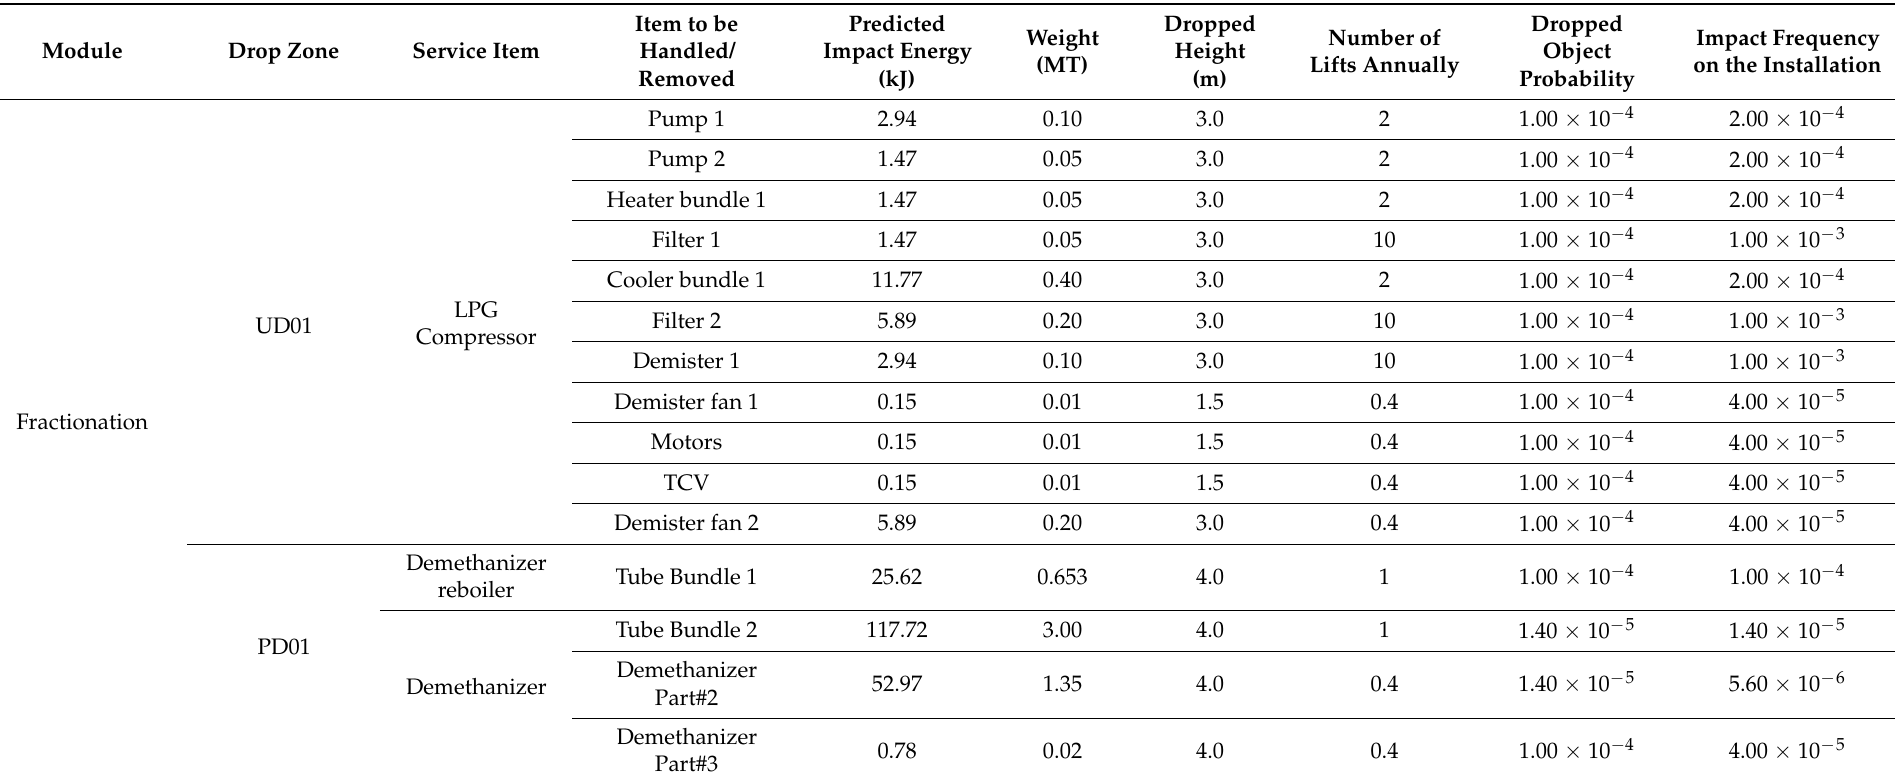
Table 3. Dropped object impact energy in the drop zones